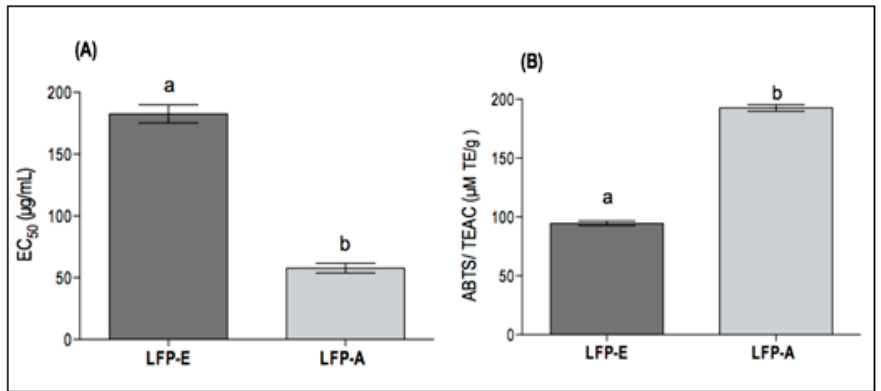
Figure 2. Antioxidant capacity of A. crassiflora extracts: ( A ) EC 50 values of DPPH radical scavenging, ( B ) Total antioxidant capacity based on ABTS method. a,b Different letters represent statistical difference by Tukey test ( p < 0.05).